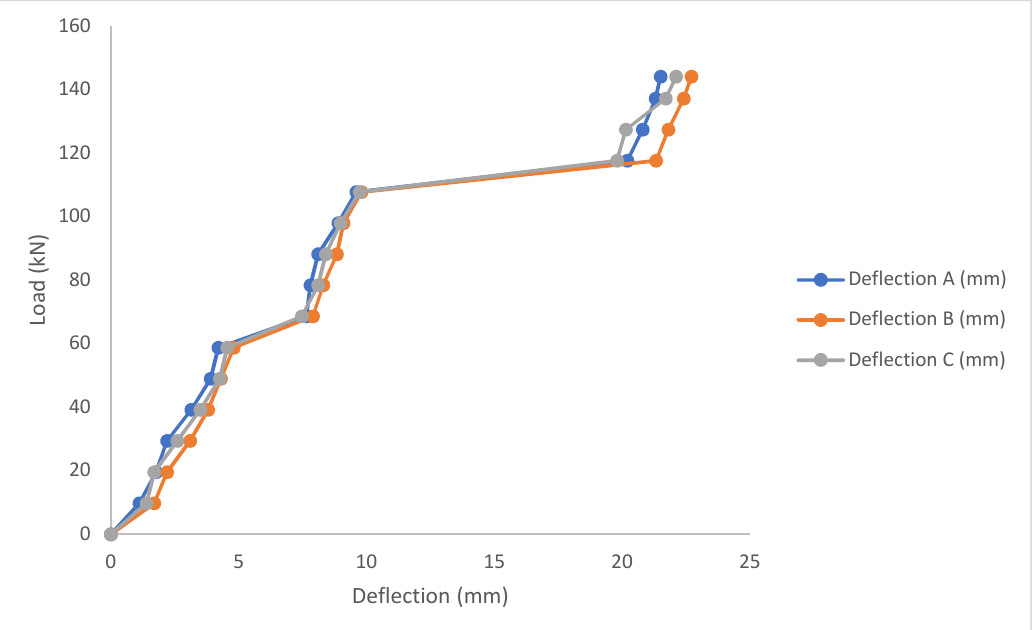
Figure 11. Load deflection plot for bamboo laminate corroded beam.